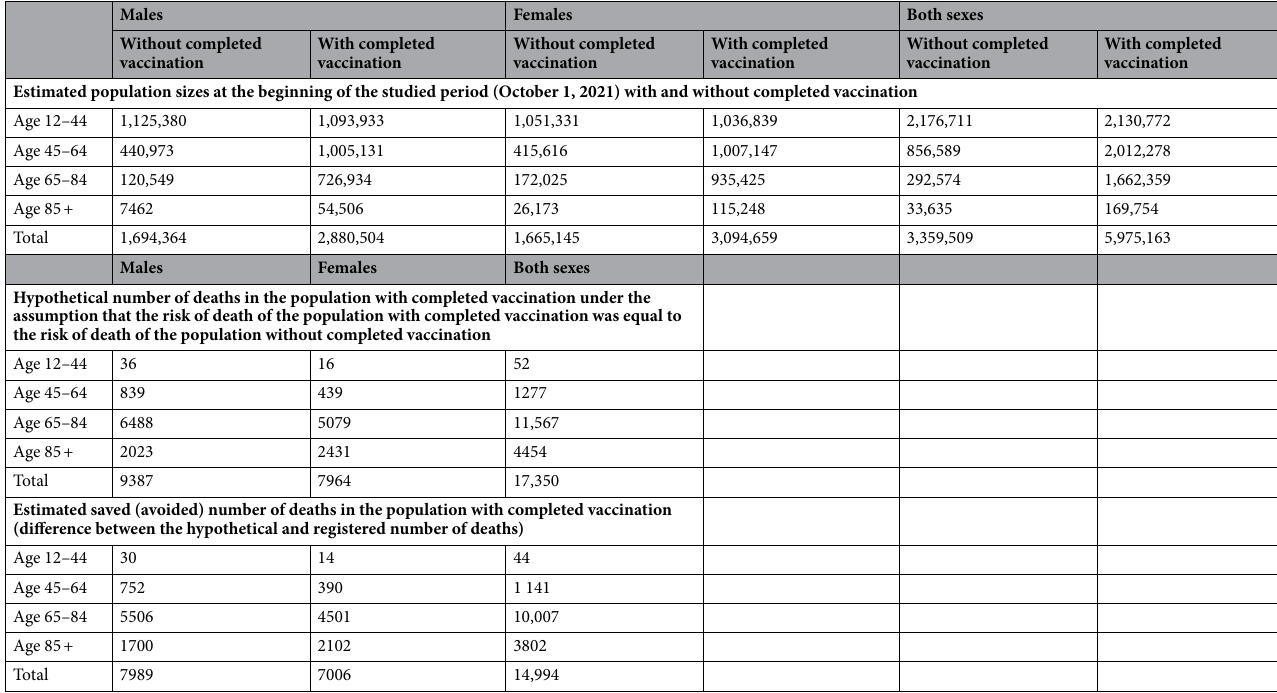
Table 2. Estimated population sizes at the beginning of the studied period (October 1, 2021) with and without completed vaccination, hypothetical numbers of deaths (population with complete vaccination) and